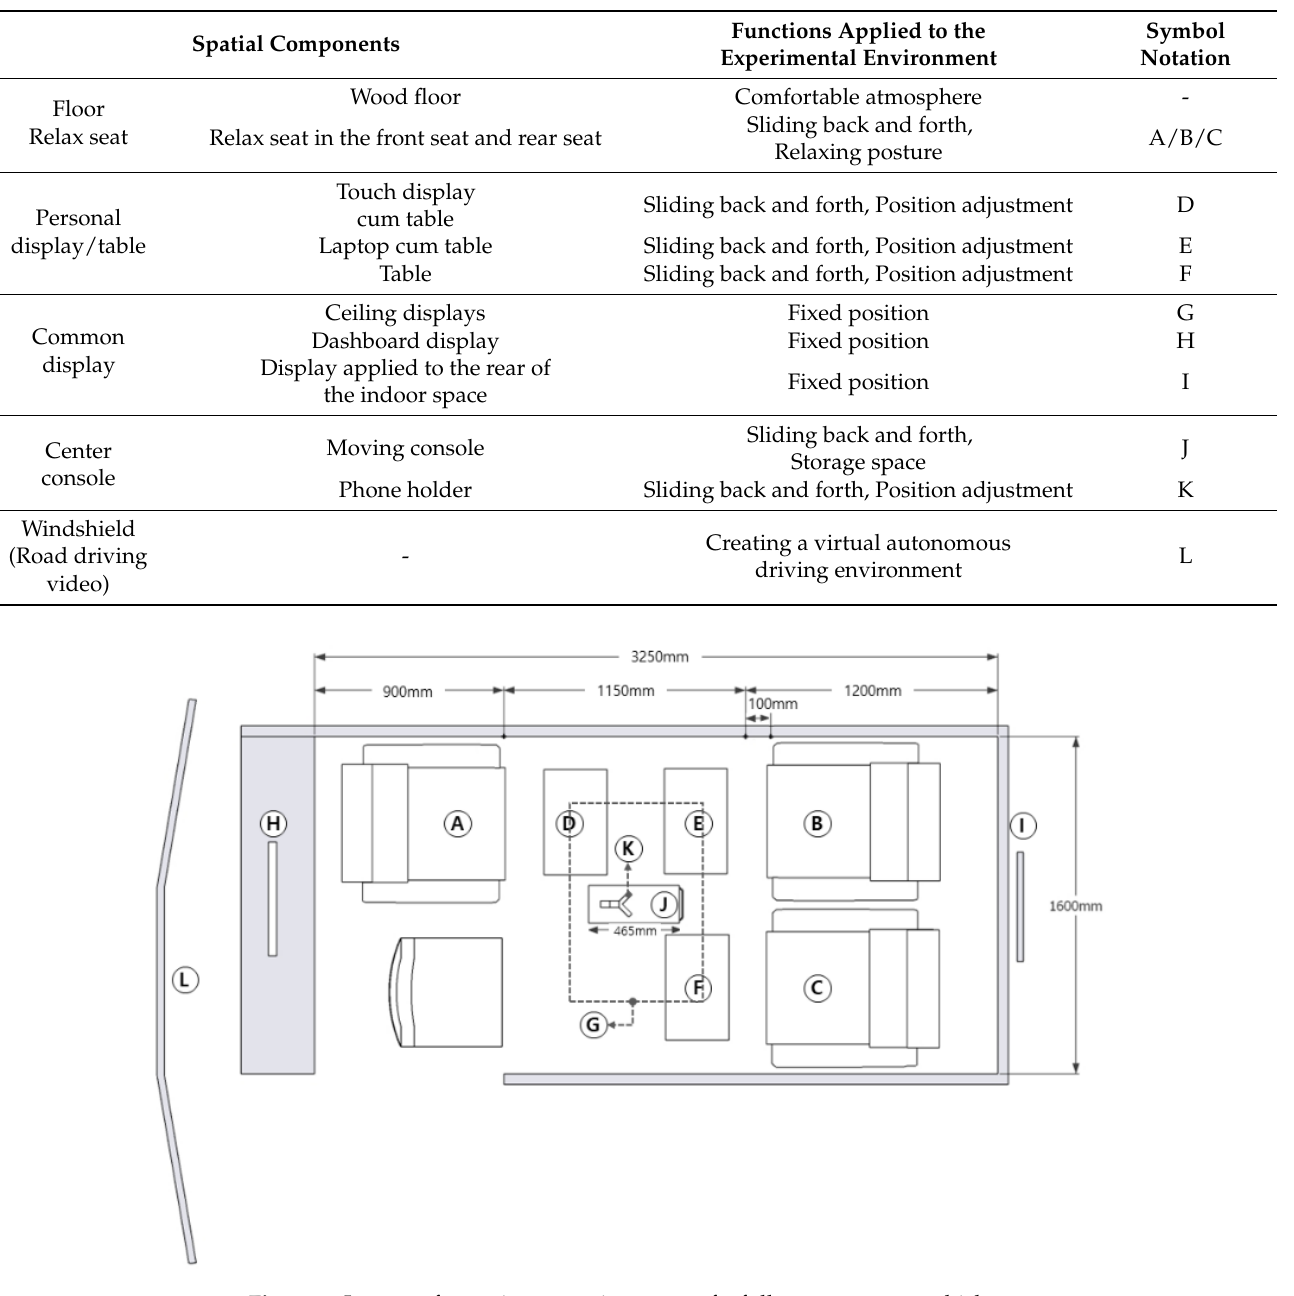
Figure 2. Experimental design of the interior environment of a fully autonomous vehicle. This study can be used to design smaller vehicles. In many cases, automotive OEMs design large vehicles and then apply them to smaller vehicles. Flexible layout is also being introduced in sedan and micro vehicle concepts (Table 5). The sedan concept is being an- nounced as an indoor space that supports in-vehicle activities included in the results of this study. Therefore, a sedan has a similar interior design to an SUV. However, since the sedan’s indoor sp ace is smaller than an SUV, there is a tendency to intensively design the more important seats of the front or rear seats depending on the level of autonomous